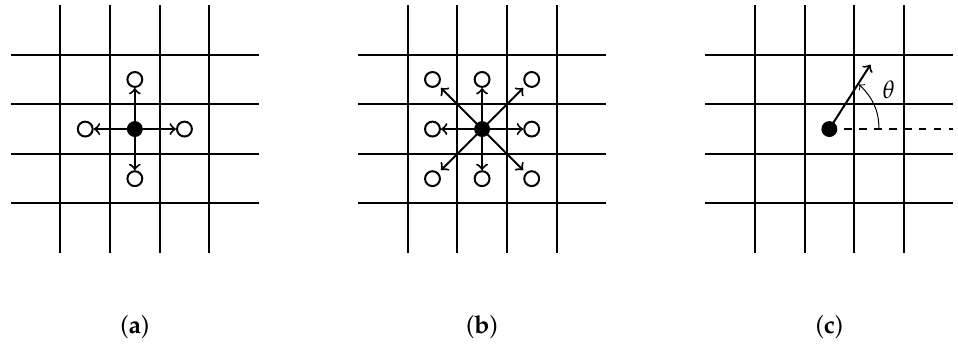
Figure 1. Schematics of possible Eden model cluster growth regiments, in which −• is a seed and −◦ is a growth site. ( a ) Represents four sites: Up, down, left, and right bordering a seed. ( b ) Adds the four diagonals to the previous regiment so there are eight possible directions for a seed to grow. ( c ) The growth direction is chosen by an angle θ = 2 π / K for a prescribed value K